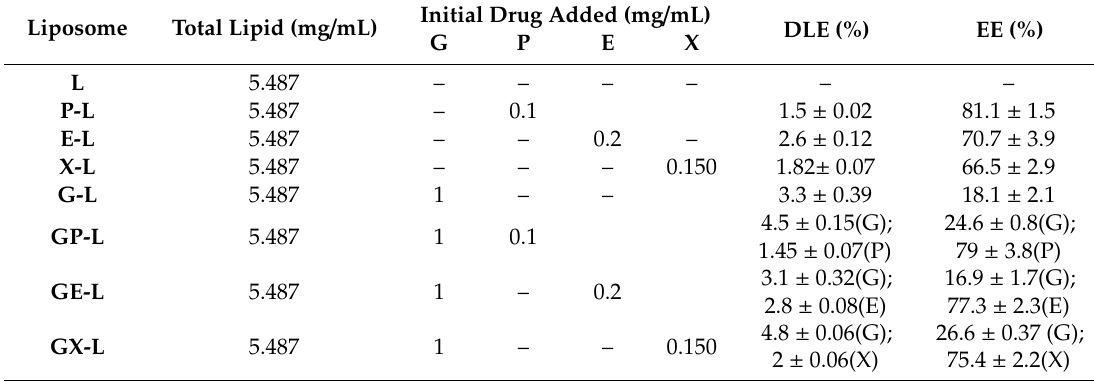
Table 2. Total lipid weight, initial drug amount added, drug-loading e ffi ciency (DLE), and encapsulation e ffi ciency (EE) of single or dual drug-loaded liposomal formulations.